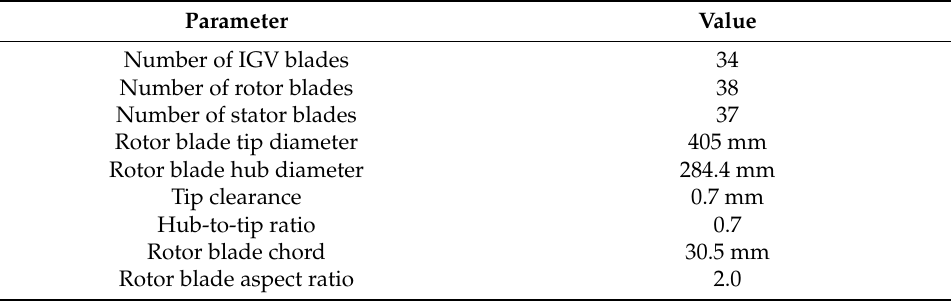
Table 12. Specification of the experimental Peregrine compressor.